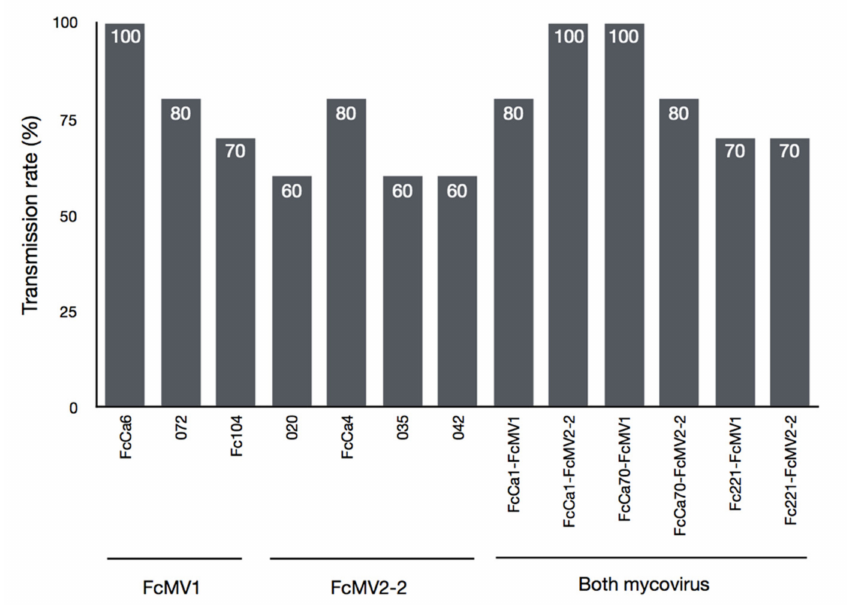
Figure 2. Transmission rate (%) of every strain of the virus in the F. circinatum isolates under